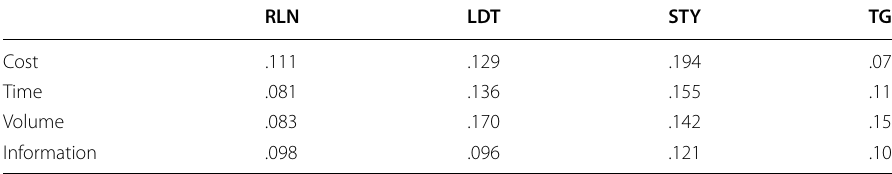
Table 15 Weighted matrix